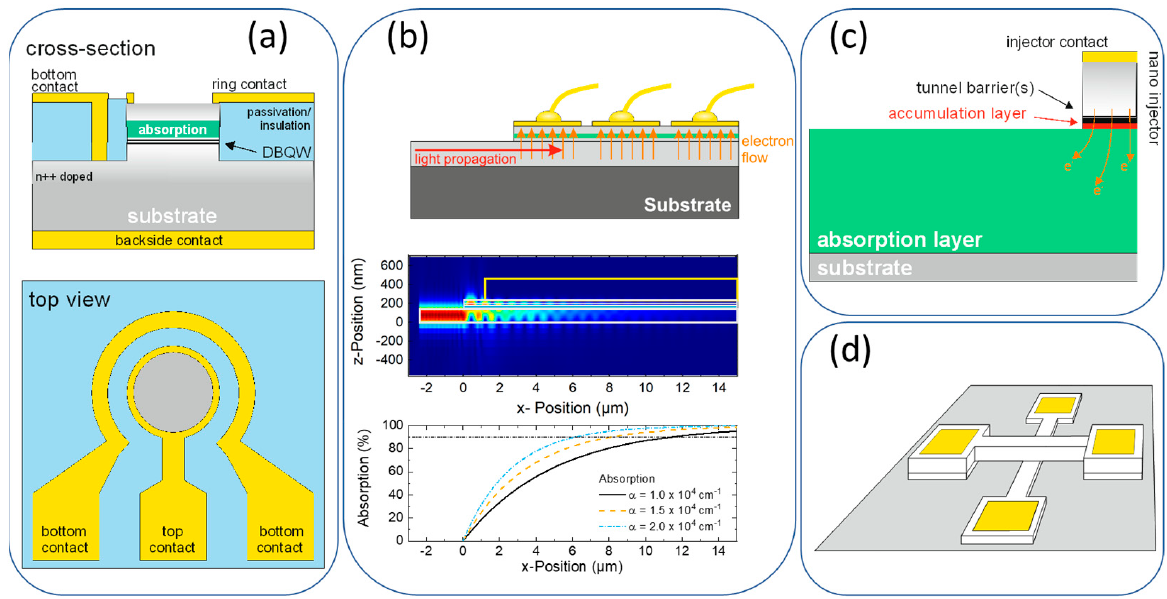
Figure 5. Comparison of different device geometries. ( a ) Ring contact geometry for easy